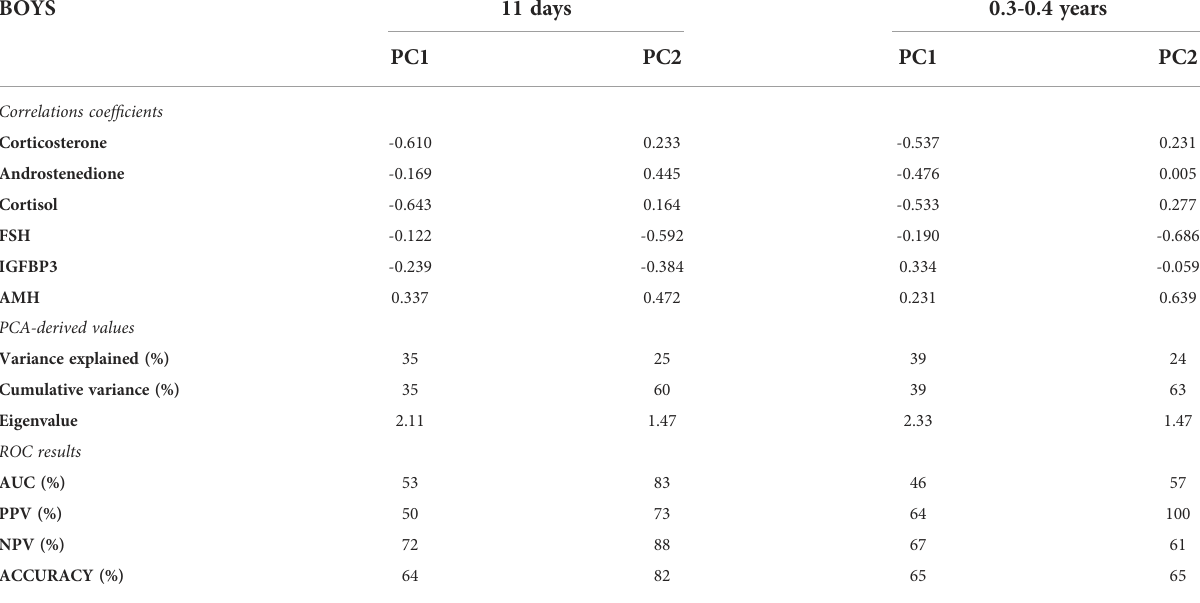
TABLE 3 Principal components and correlation coef fi cients for hormone concentrations in boys at the initial exam (median age: 11 days) and at the exam between 0.3-0.4 years of age. BOYS 11